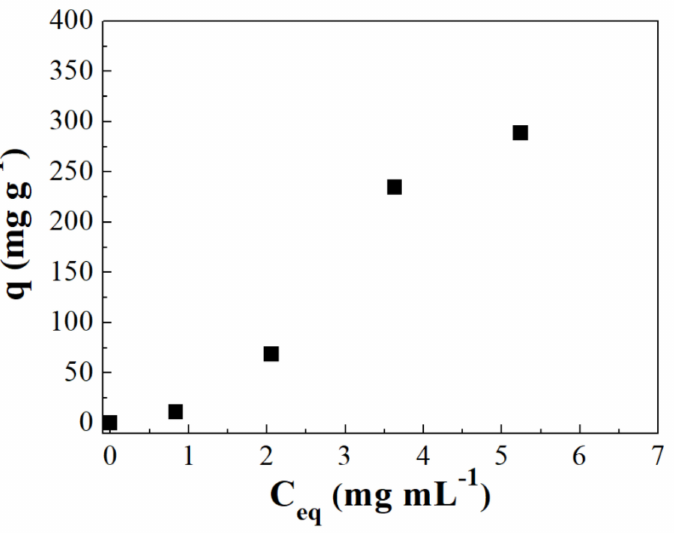
Figure 7. Batch experiments for human serum adsorption in SBA-15-FTMB. Contact time (4.0 h), mass of adsorbent (15 mg), volume of sample (3.0 mL) and buffer TRIS/HCl 25 mM at pH 9.0. Protein quantification by Bradford